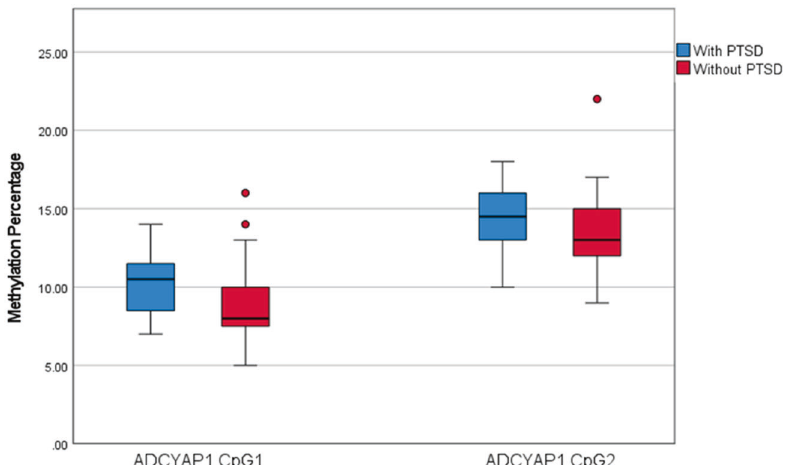
Fig. 2 Posttraumatic stress disorder (PTSD) status and ADCYAP1 methylation percentage. Boxplots indicating methylation levels between participants with and without PTSD for the two CpG sites in the ADCYAP1 region were found to be associated with PTSD in the epigenome- wide methylation